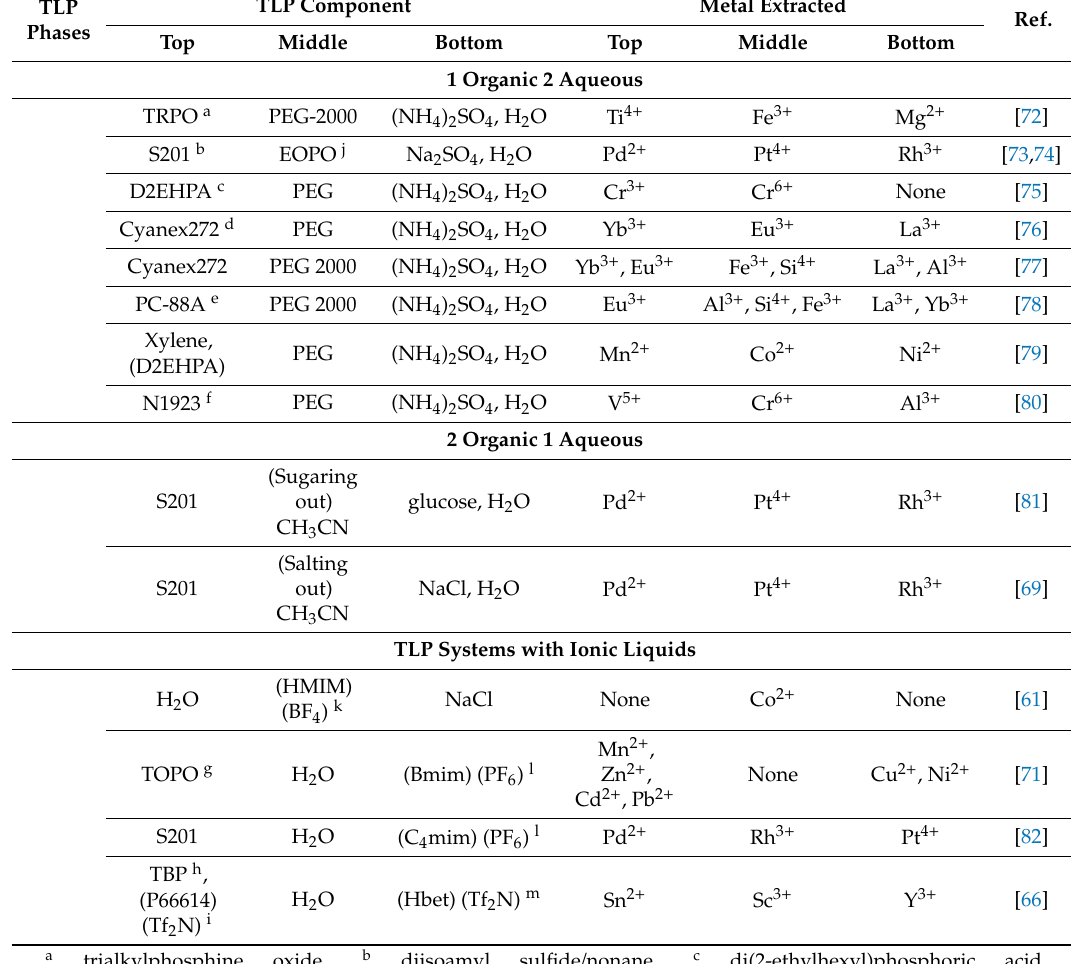
Table 2. TLP systems for metal ion